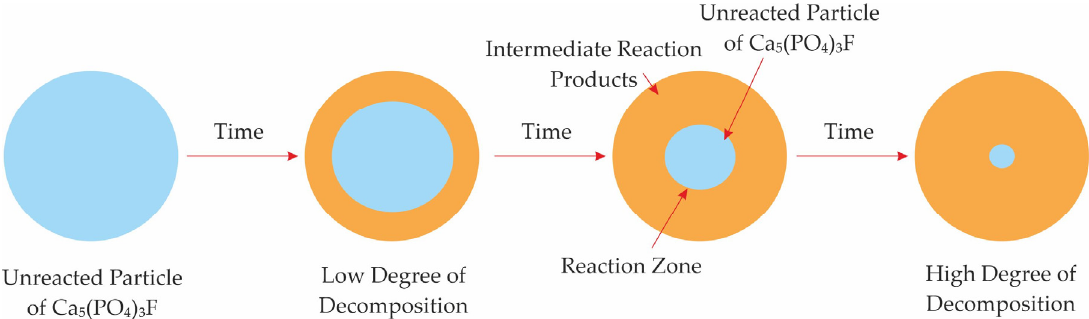
Figure 5. According to the model of a particle with a non-interacting nucleus, the reaction proceeds on its outer surface, and the reaction zone moves frontally into the particle, leaving behind the particle substance completely converted into reaction products.